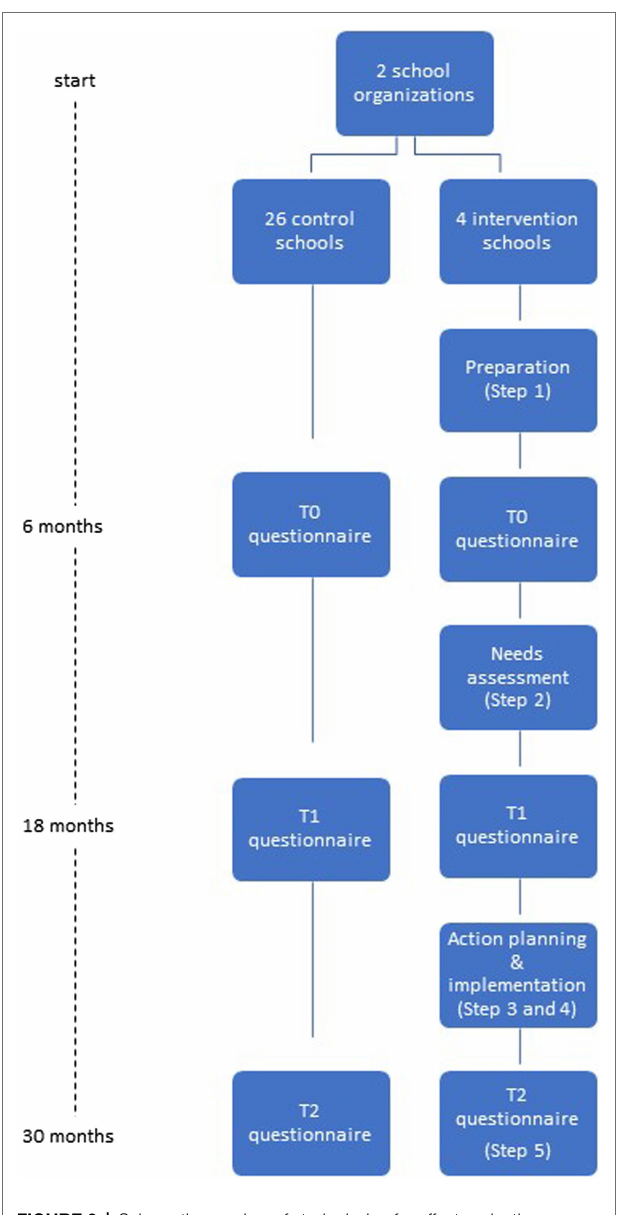
FIGURE 3 | Schematic overview of study design for effect